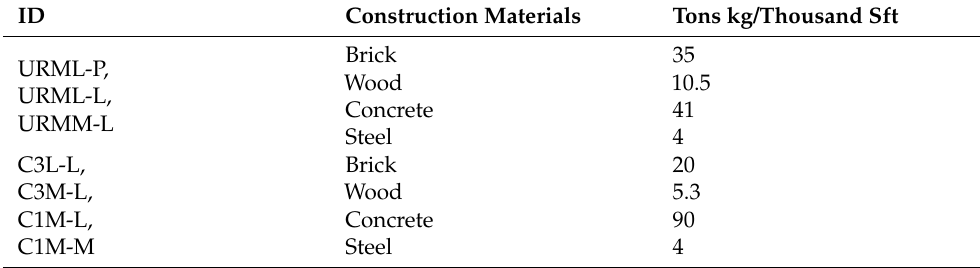
Table A2. Construction material composition for different building types.